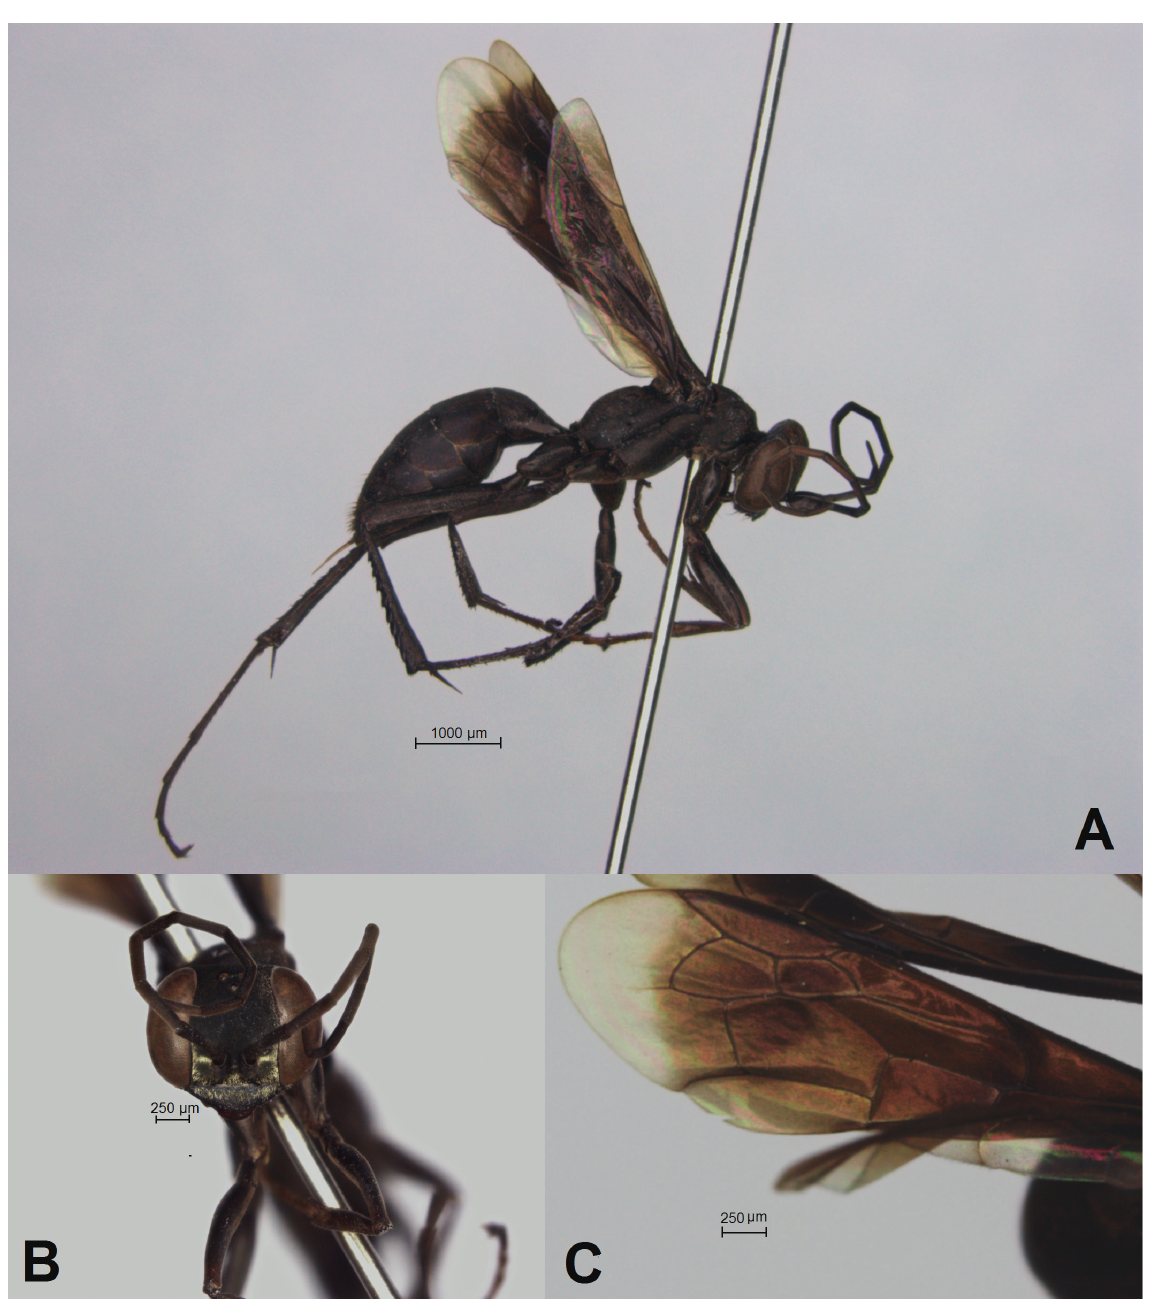
Fig. 3. Ageniella ruschi sp. nov., ♀, holotype (UFES). A . Profile. B . Head, frontal view. C . Fore